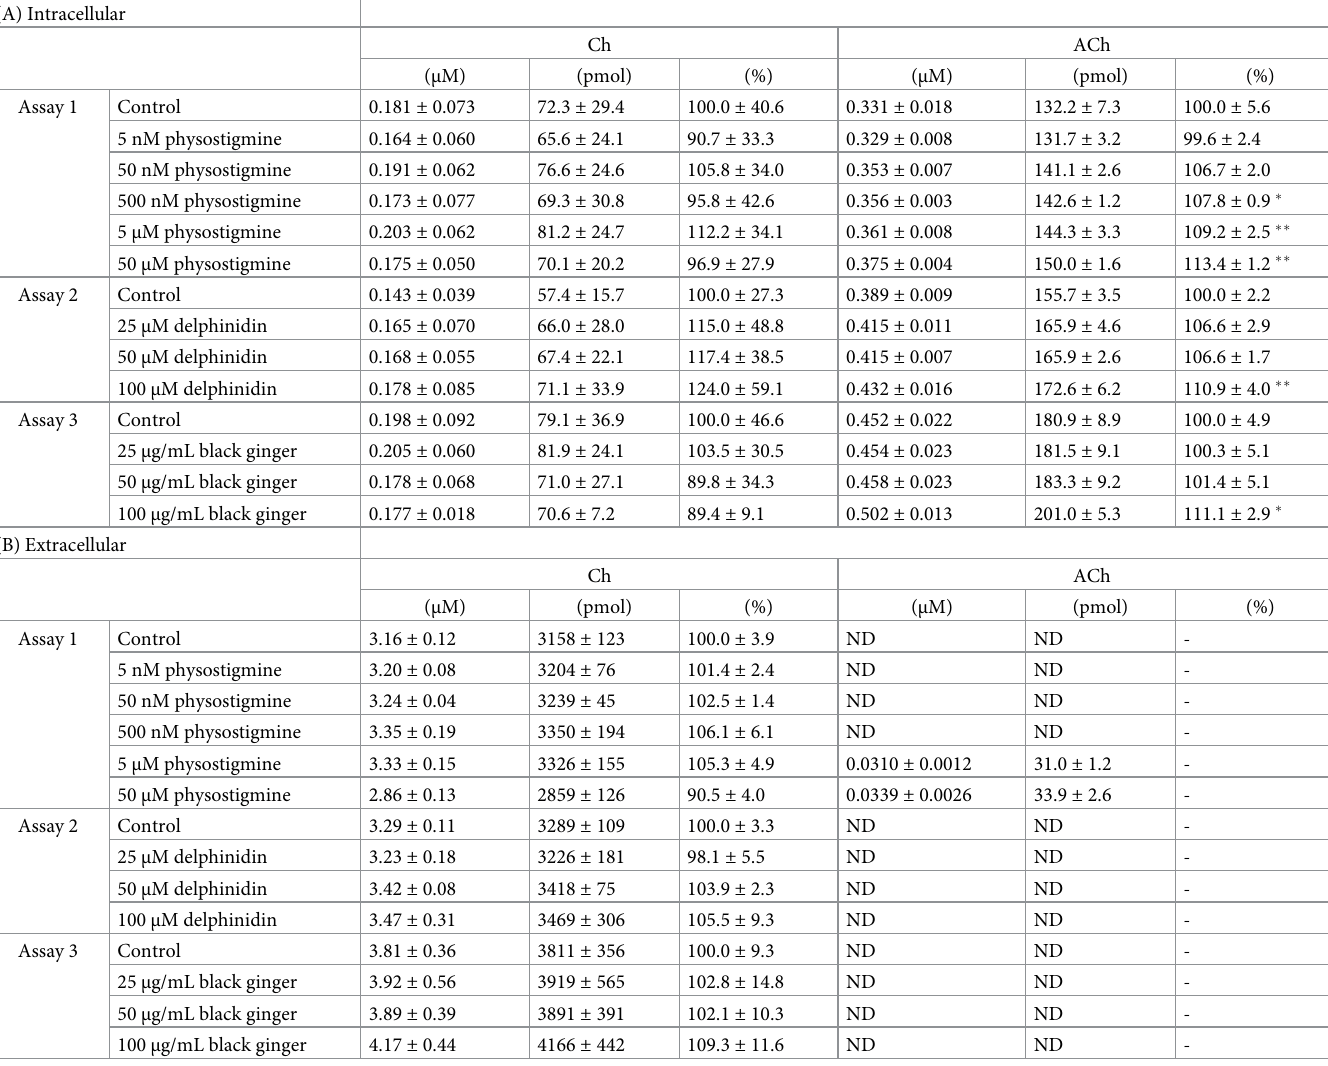
Table 1. Changes in the choline and acetylcholine levels in LA-N-2 cells after treatment with physostigmine, delphinidin, and black ginger extract, which have been reported to have AChE-inhibiting activity. (A) Intracellular